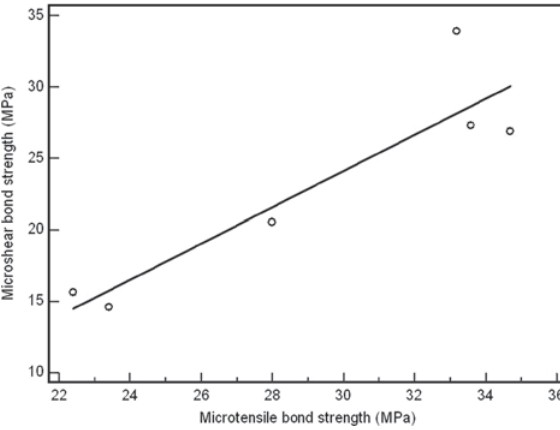
Figure 3- Linear relationship between microshear (MPa) and microtensile bond strength means